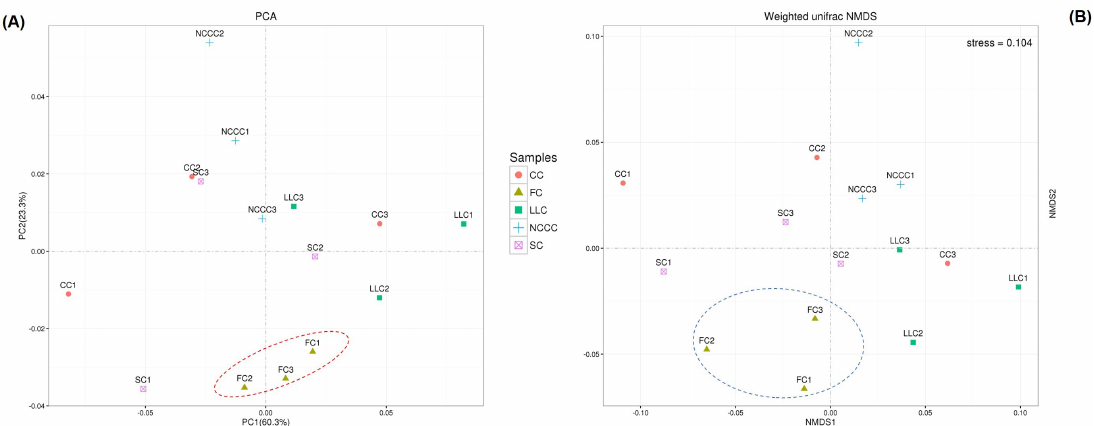
Figure 3. Sample sorting analysis revealed the microbial community ordination plots for 16S rRNA bacteria: ( A ) scatter plots based on UniFrac phylogenetic distances with principal component analysis (PCA) ordination (PC1 vs PC2), sampling di ff erences with non-metric multidimensional scaling of Unifrac weighted non-metric multidimensional scaling (NMDS) ( B